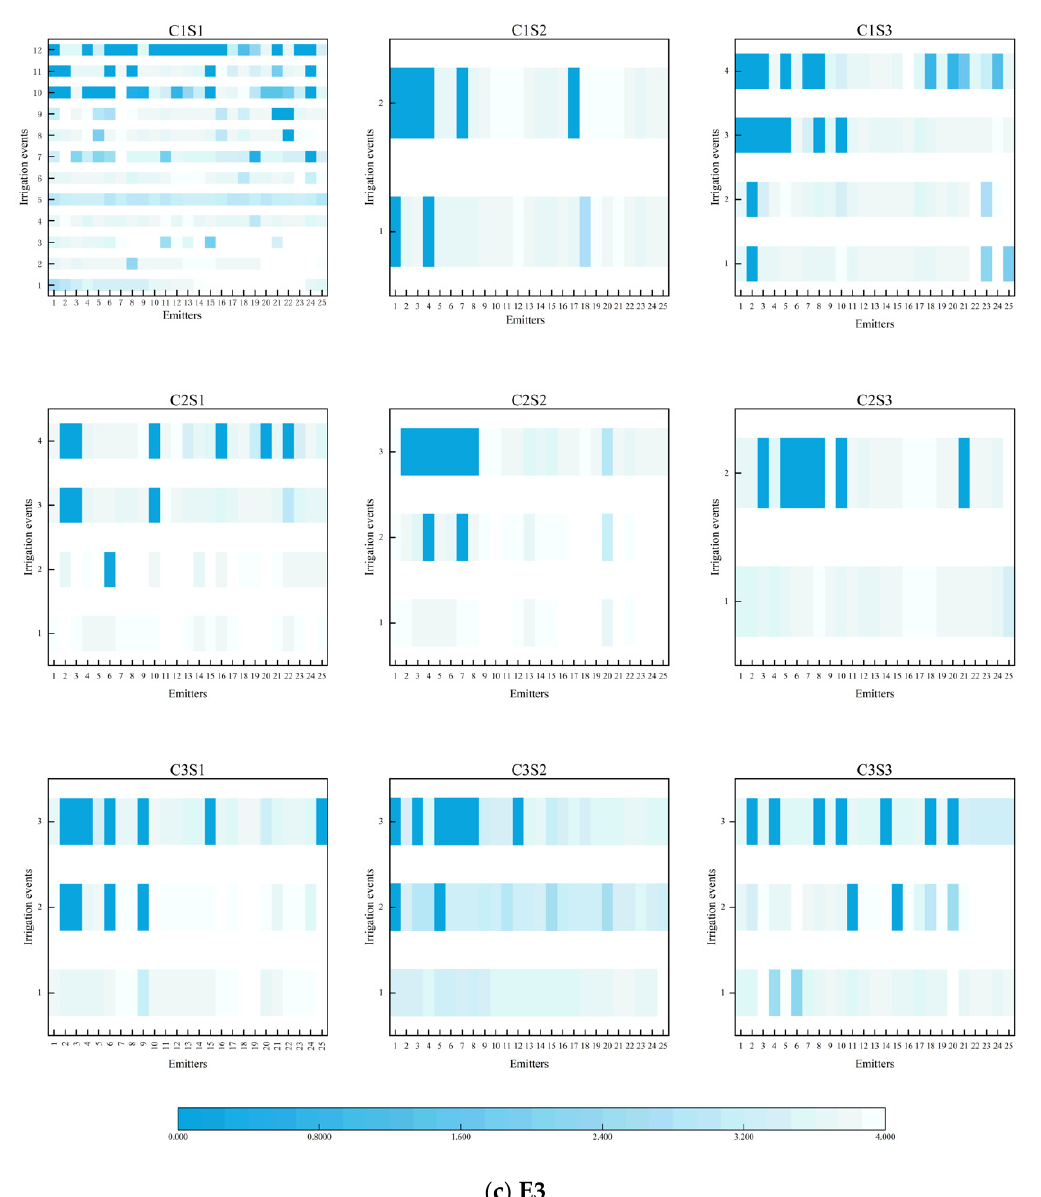
Figure 4. Clogging distribution of drip irrigation tapes. ( a ) The distribution is the flow along the drip irrigation tape 1. ( b ) The distribution is the flow along the drip irrigation tape 2. ( c ) The distribution is the flow along the drip irrigation tape 3.